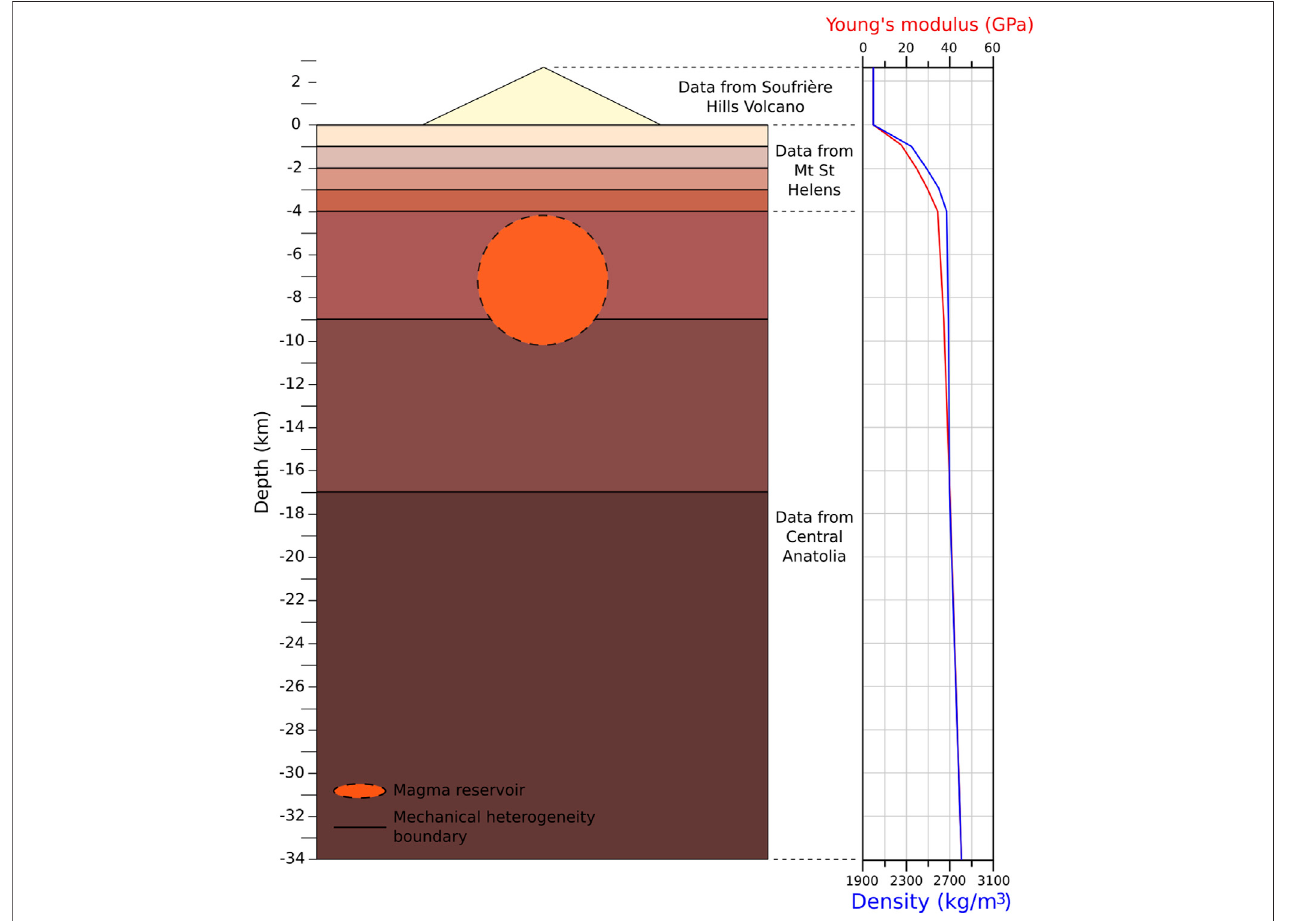
FIGURE 3 | Schematic of subsurface material properties (crustal density ρ c and crustal static Young ’ s modulus E s ) of the layered TOPO model (LTM) derived from 1DseismictomographydataofcentralAnatolia(Salahetal.,2014)using Eqs8 – 10 .Intheabsenceofshallowcrustaldataforthevolcanoandsurroundingareas,weuse seismic data from the Cascades around Mt St Helens (Kiser et al., 2016). Edi fi ce properties are taken from Soufrière Hills Volcano (Young and Gottsmann, 2015). An idealisedtopographicreliefofErciyesDa ğ isshownforsimplicityrising ∼ 3 kmfromthesurroundingplateau( z (cid:1) 0).Digitalelevationdataisusedtoparameterise the topographicsurfaceintheFiniteElementmodels.Themagmareservoirisrepresented byaspherewithitscentroidlocateddirectlybeneaththesummitofthevolcanoat a depth of z (cid:1) − 7 km.